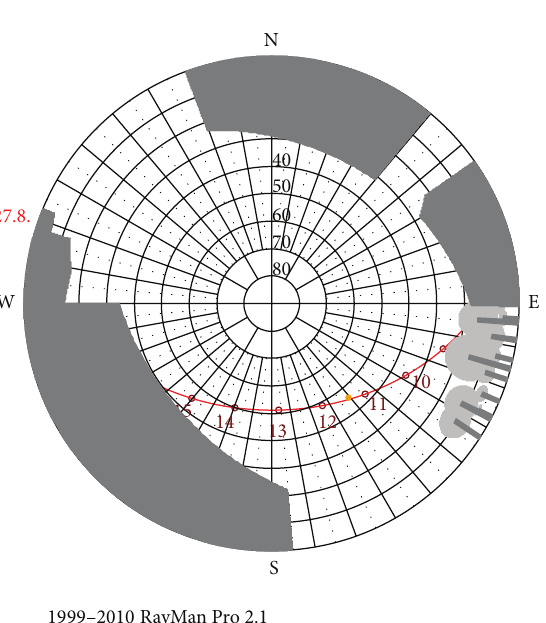
Figure 13: Polar diagram for the sky view factor (zone 3) in